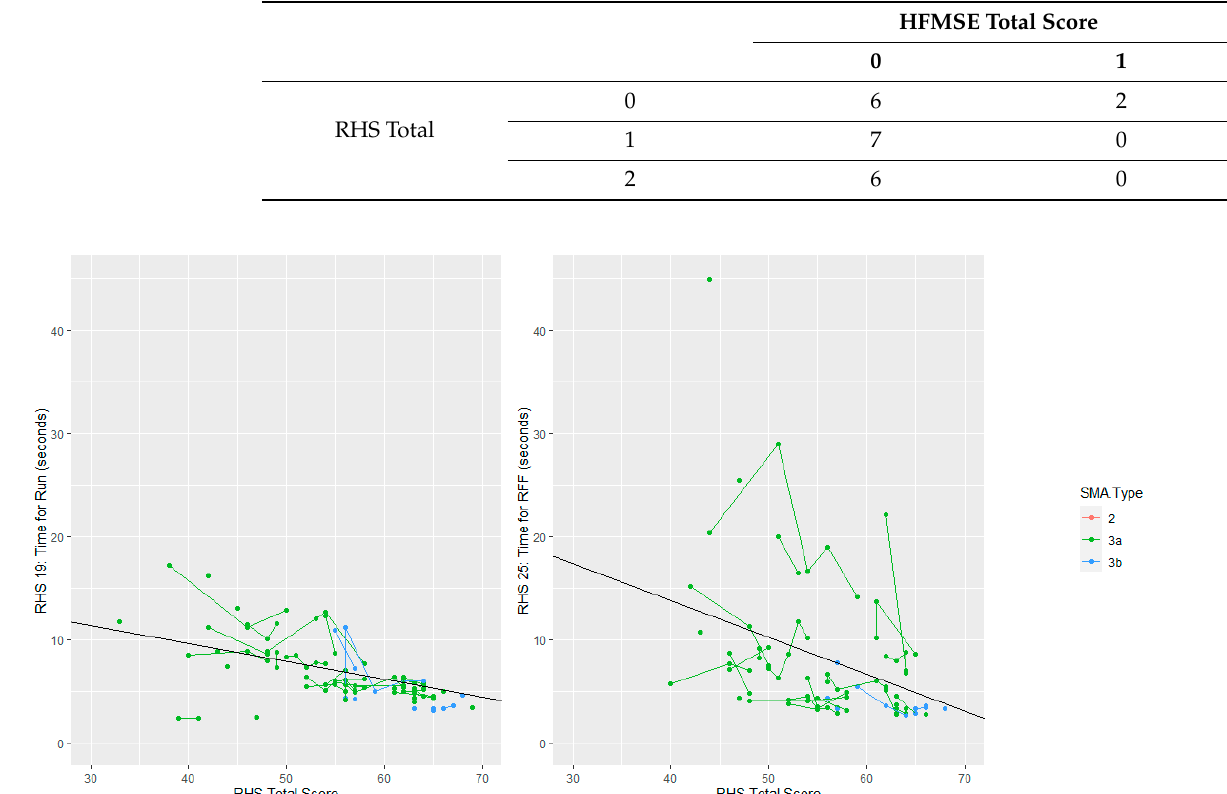
Table 6. Breakdown of RHS and HFMSE total scores in assessments where at least one was 0.